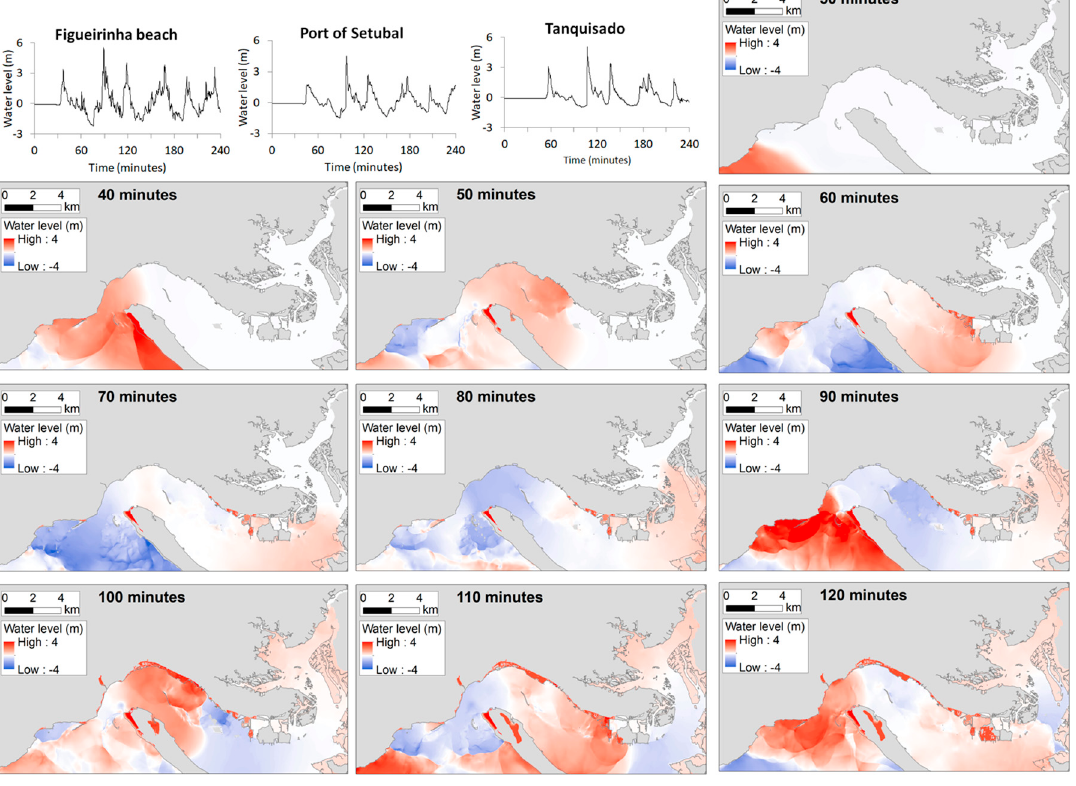
Figure 10. Water level waveforms and snapshots of the 1755 tsunami.